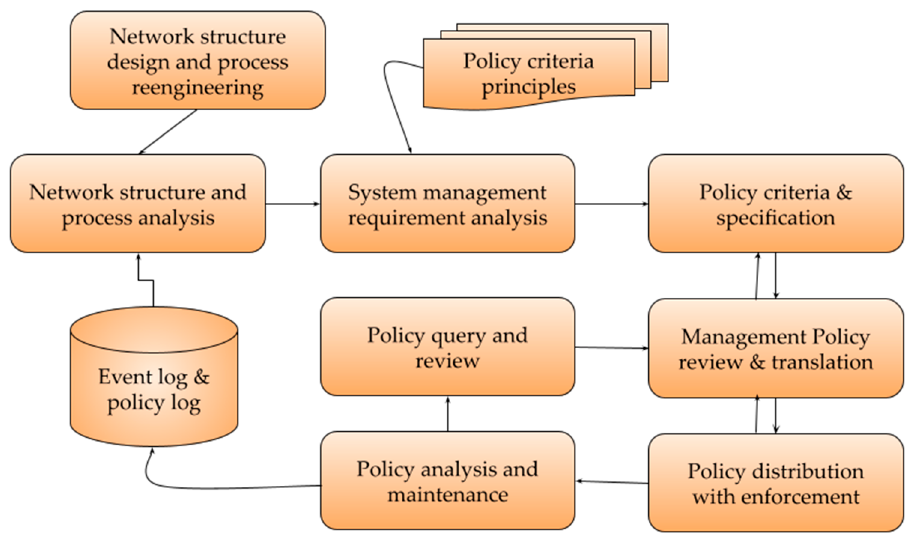
Figure 2. Policy lifecycle